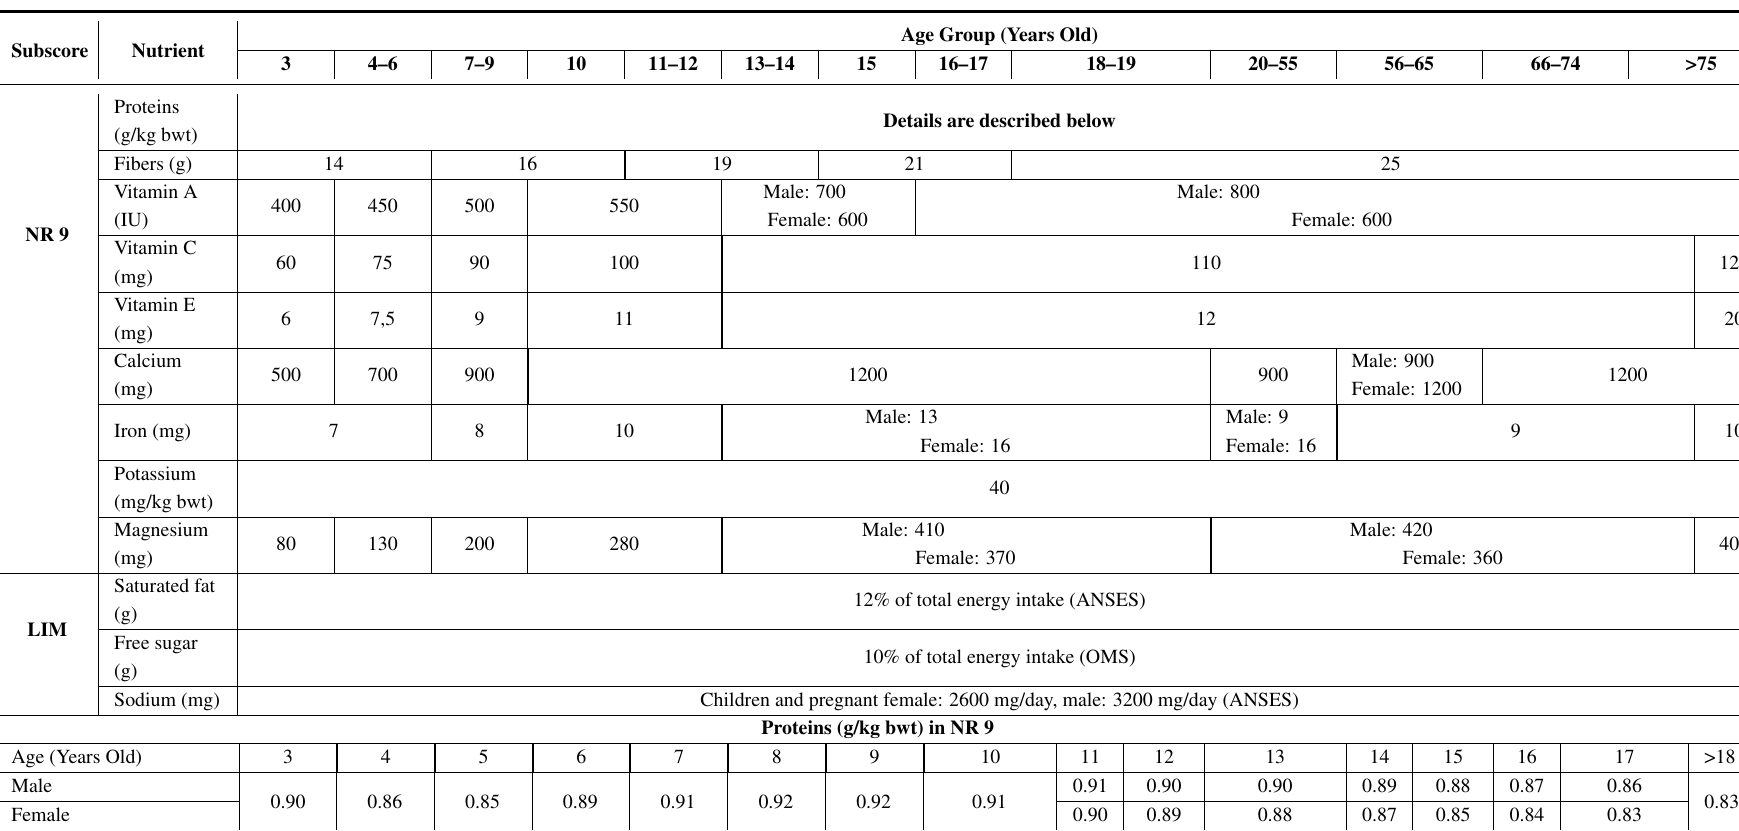
Table 1. Recommended dietary amounts (Apports Nutritionnels Conseilles or ANC) in France by age and gender for use with nutrient rich food (NRF)